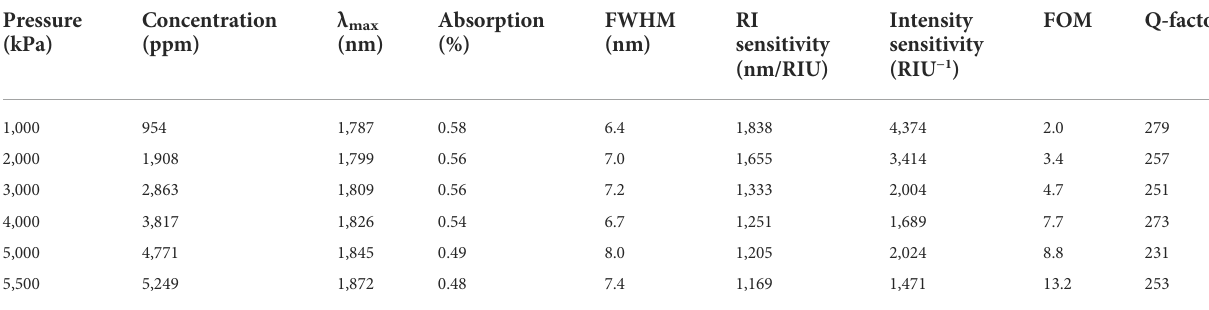
TABLE 5 CO 2 pressure, concentration, peak wavelength, absorption, FWHM, RI sensitivity, intensity sensitivity, FOM, and Q-factor for group G3. Pressure (kPa)